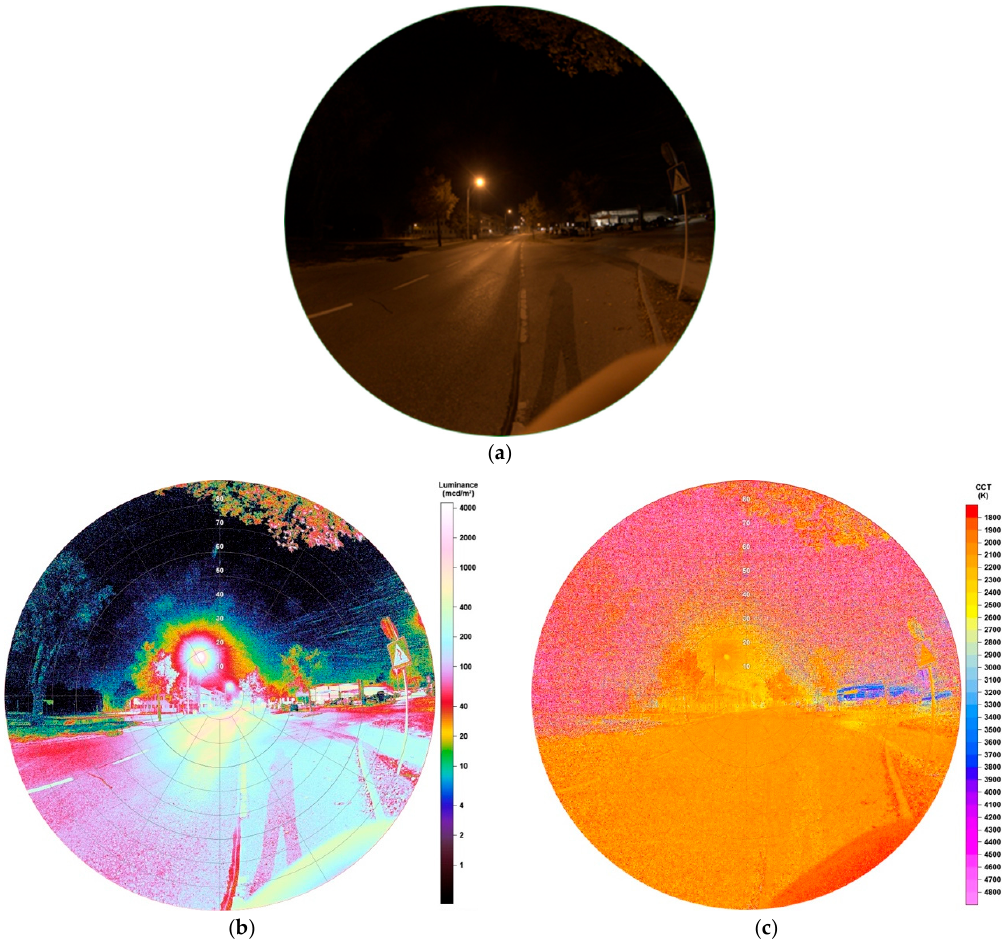
Figure 2. ( a ) Image of HPS lamp during night-time taken with fisheye lens for detailed analysis (date: 10.10.2018, 23:54 h; exposure time: 0.2 s); ( b ) Luminance matrix of image (a) as displayed by Sky Quality Camera (SQC); ( c ) Colour correlated temperature (CCT) matrix of image (a) as displayed by SQC.